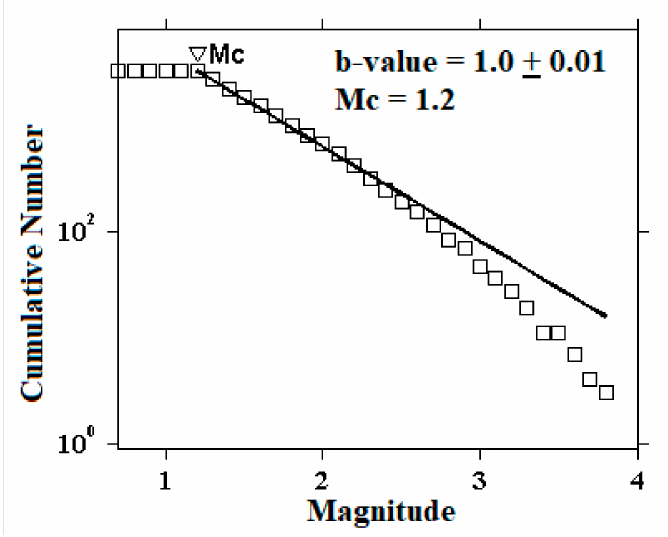
Figure 3. Frequency magnitude distribution with respect to M L . The straight line is the best fit by Gutenberg and Richter (1941). The threshold magnitude, M C (triangle), and overall b-value with standard deviation are also